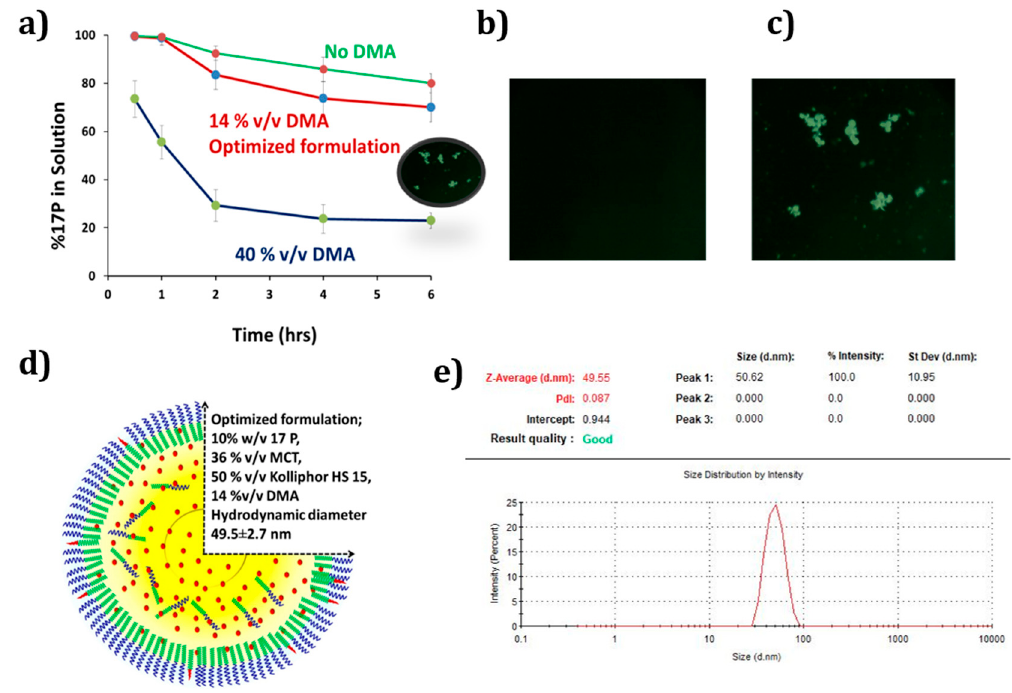
Figure 1. Characterization and optimization of 17P self nano emulsifying drug delivering system (SNEDDS). ( a ) Effect of dimethylacetamide (DMA) on physical stability of 17P-loaded SNEDDS. The